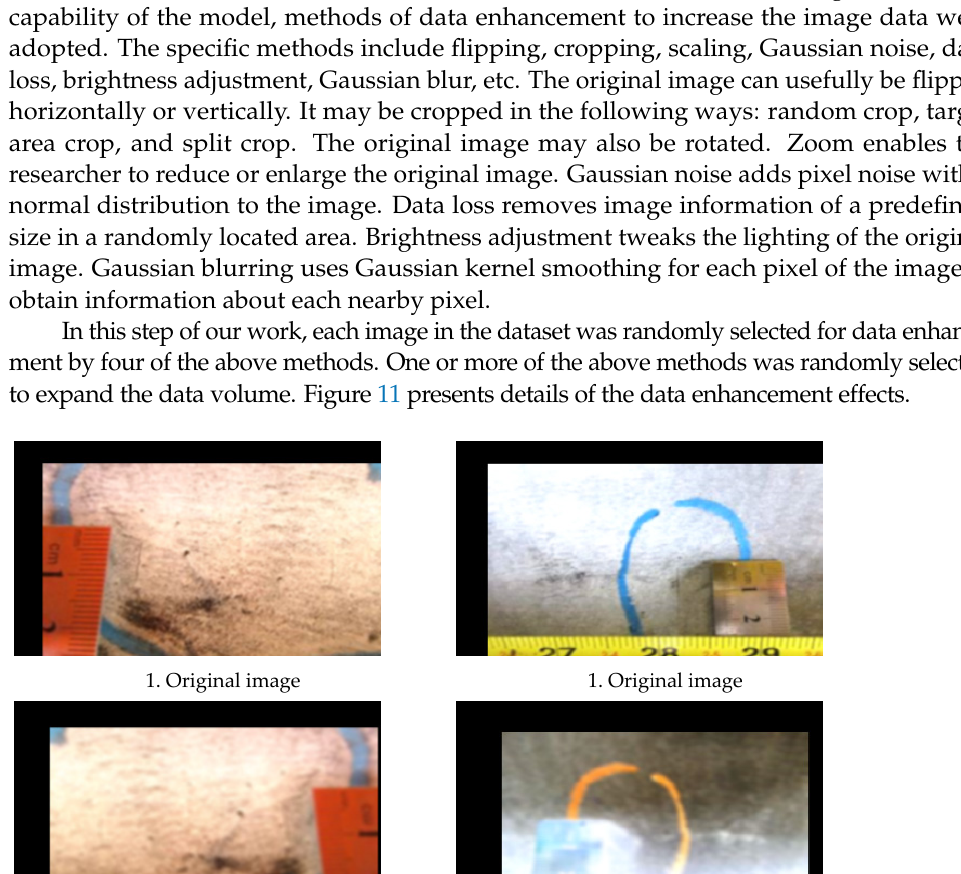
Figure 10. The crack data annotation.